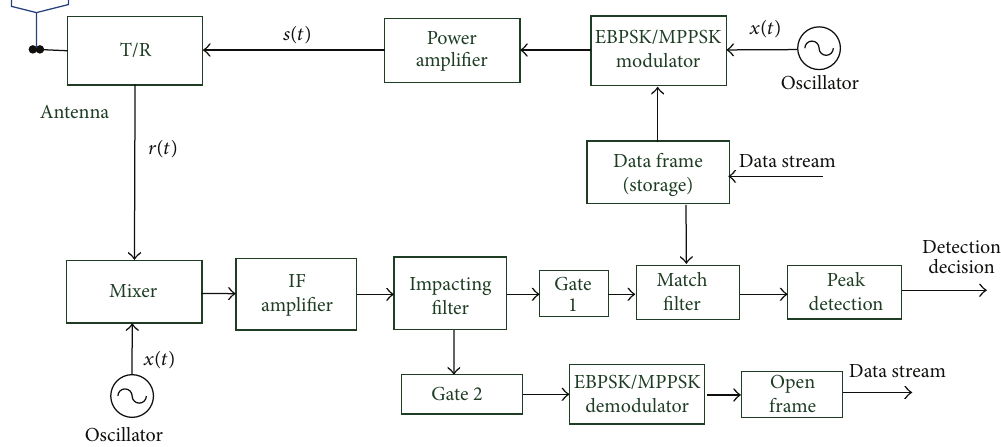
Figure 1: EBSPK-/MPPSK-modem based radar-communication